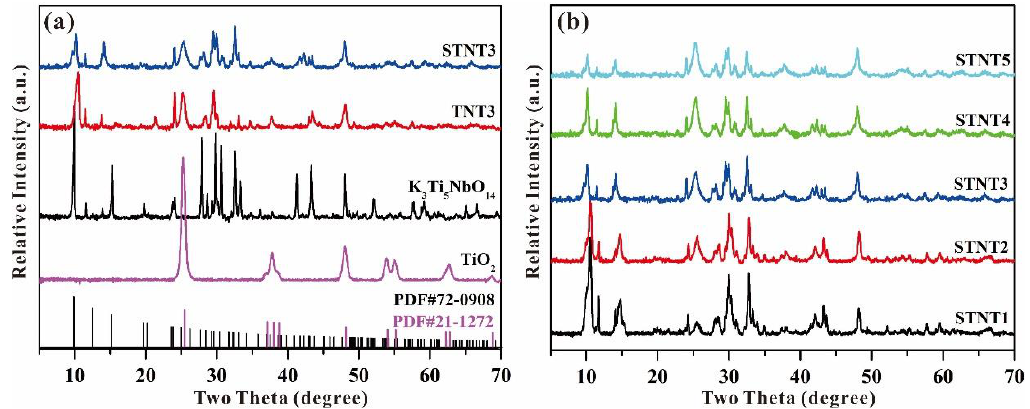
Figure 4. XRD patterns of ( a ) different samples, and ( b ) as-prepared STNT x ( x = 1 2, 3, 4, and 5)